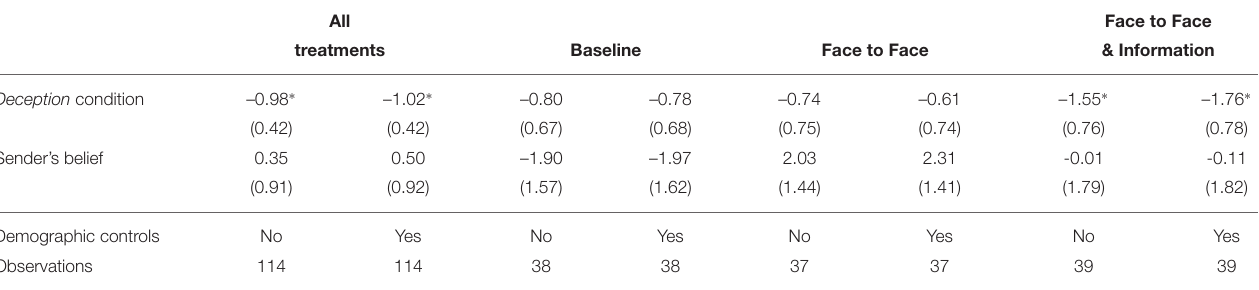
TABLE 3 | Regressions of the senders’ antisocial cost on the condition and the senders’ belief.